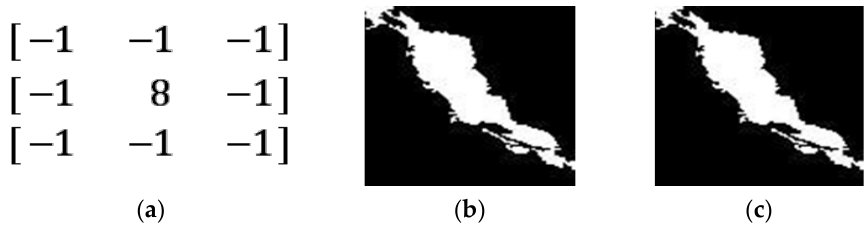
Figure 4. ( a ) convolution kernel; ( b ) image to be tested; ( c ) single-layer convolution result.